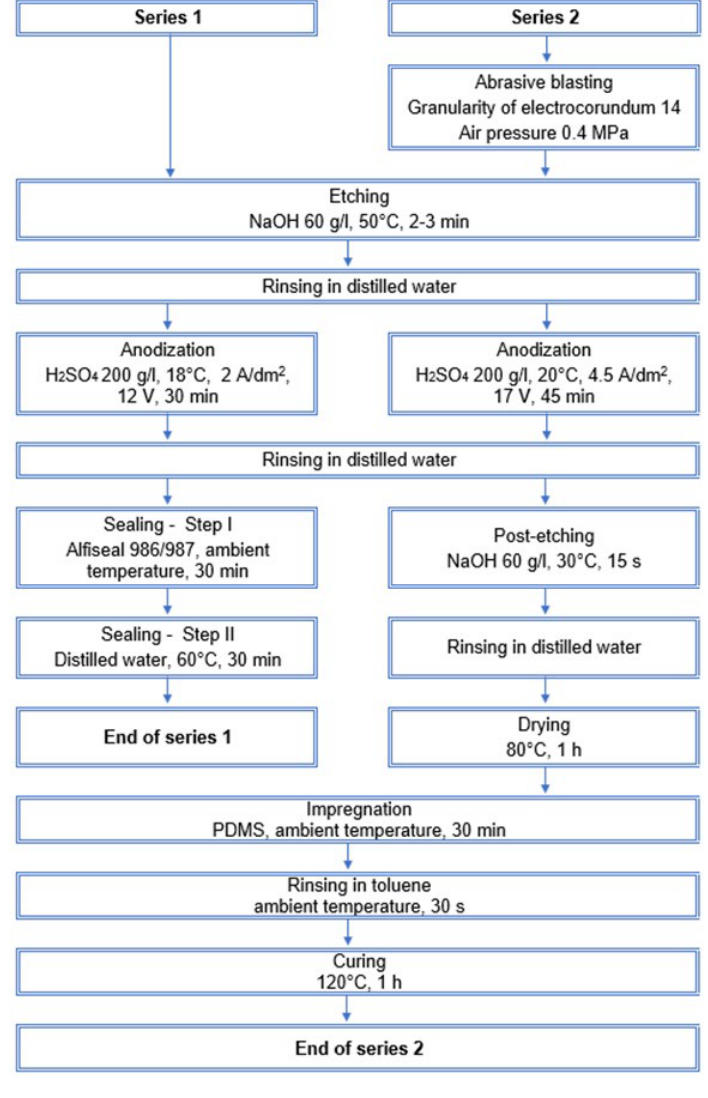
Figure 1. Manufacturing